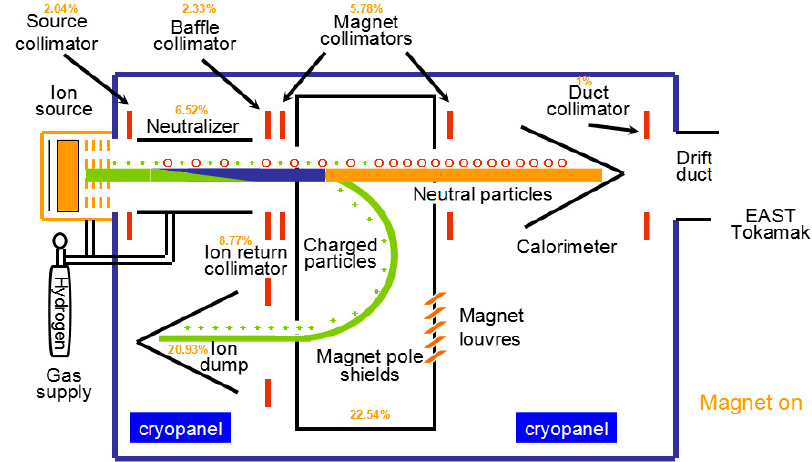
Figure 1. Basic structural diagram of the EAST tokamak NBI system.